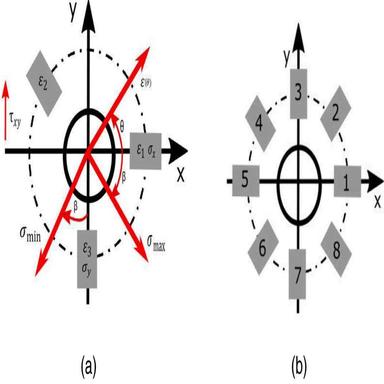
(a) Sketches of a standard clockwise strain gauge rosette and the relevant coordinate system and (b) the utilized strain gauge with eight rosettes. Recompiled from.